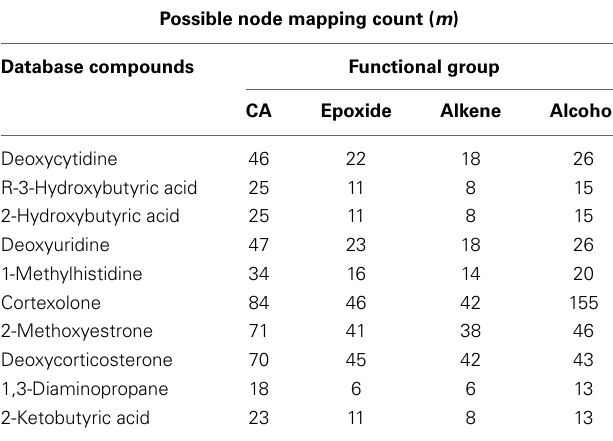
Table 1 | List of representative database compounds and functional